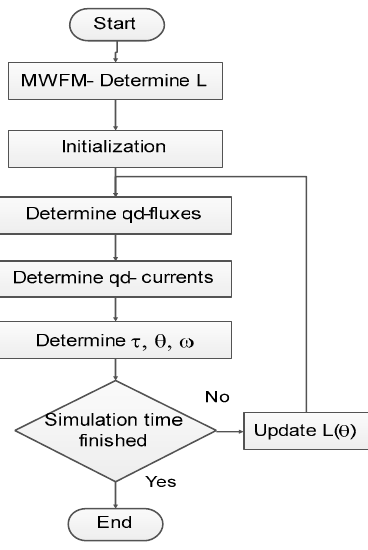
Figure 6. Flow chart of simulation process using. MATLAB ® .